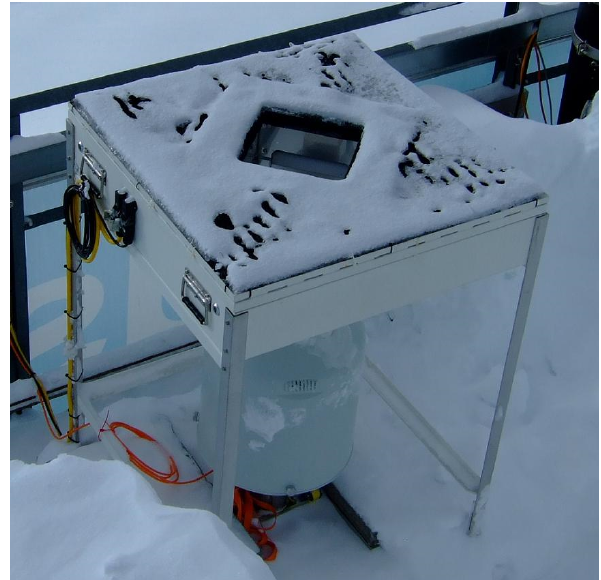
Figure 1. The compact 2-DVD at the measuring site.